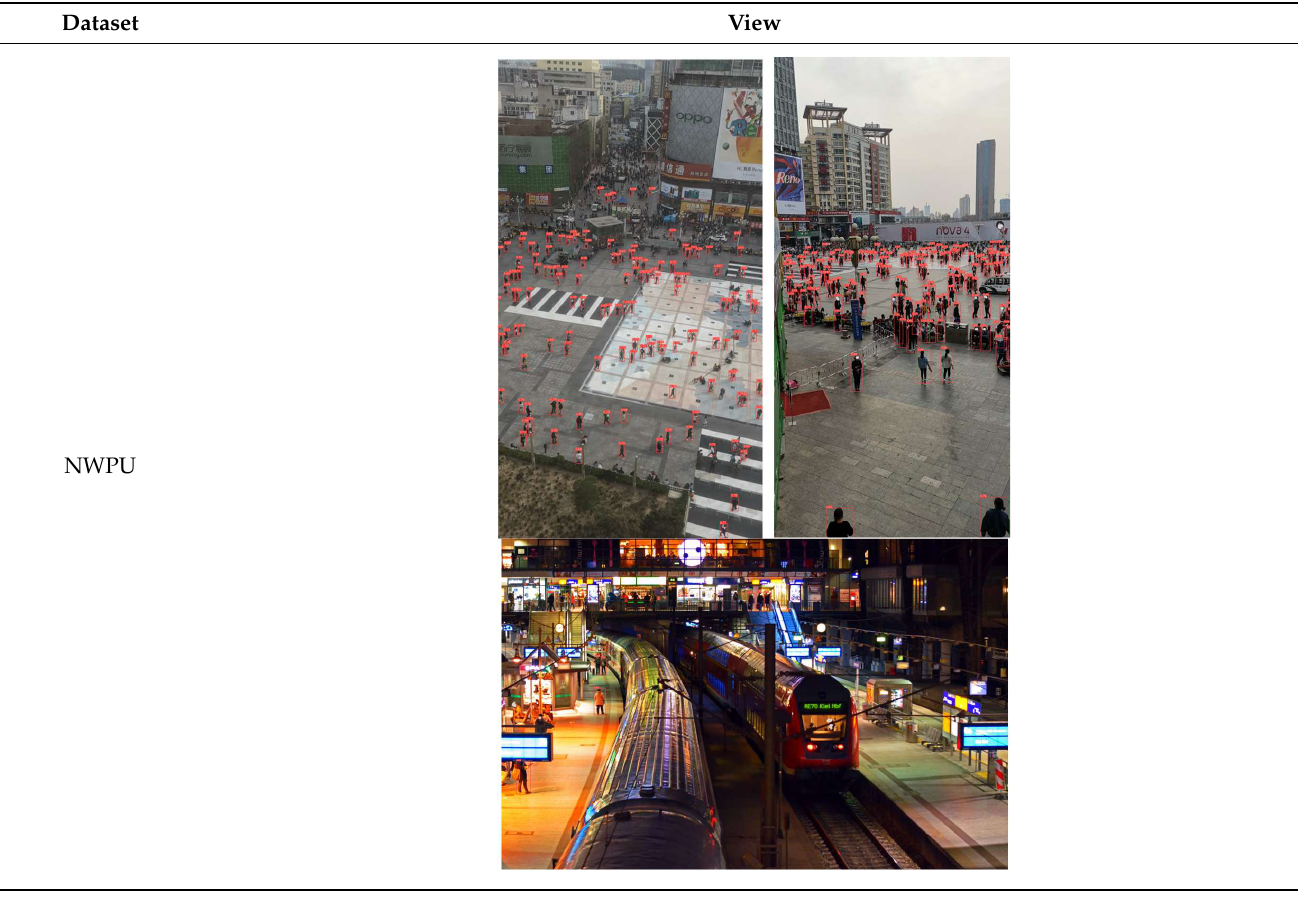
Table 8. Quantitative person detection results per selected videos/images via the custom YOLOv5s.